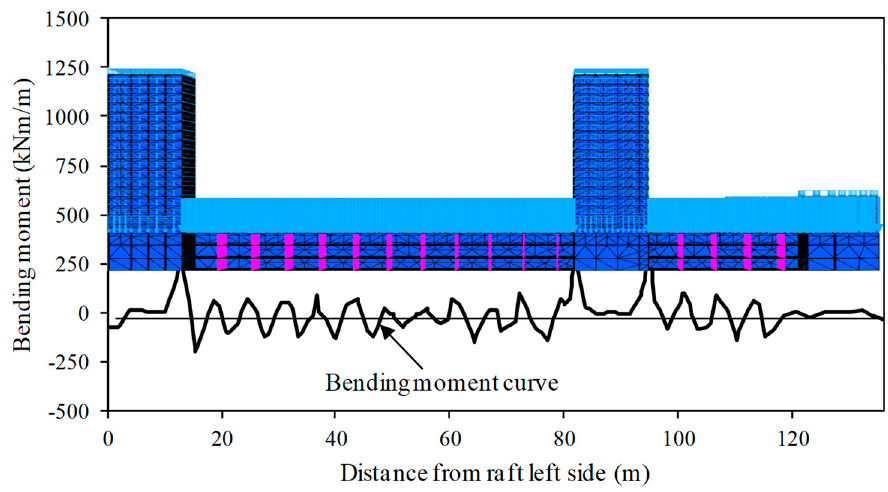
Figure 19. Distribution of moment in the center section of the raft of the high-rise buildings.